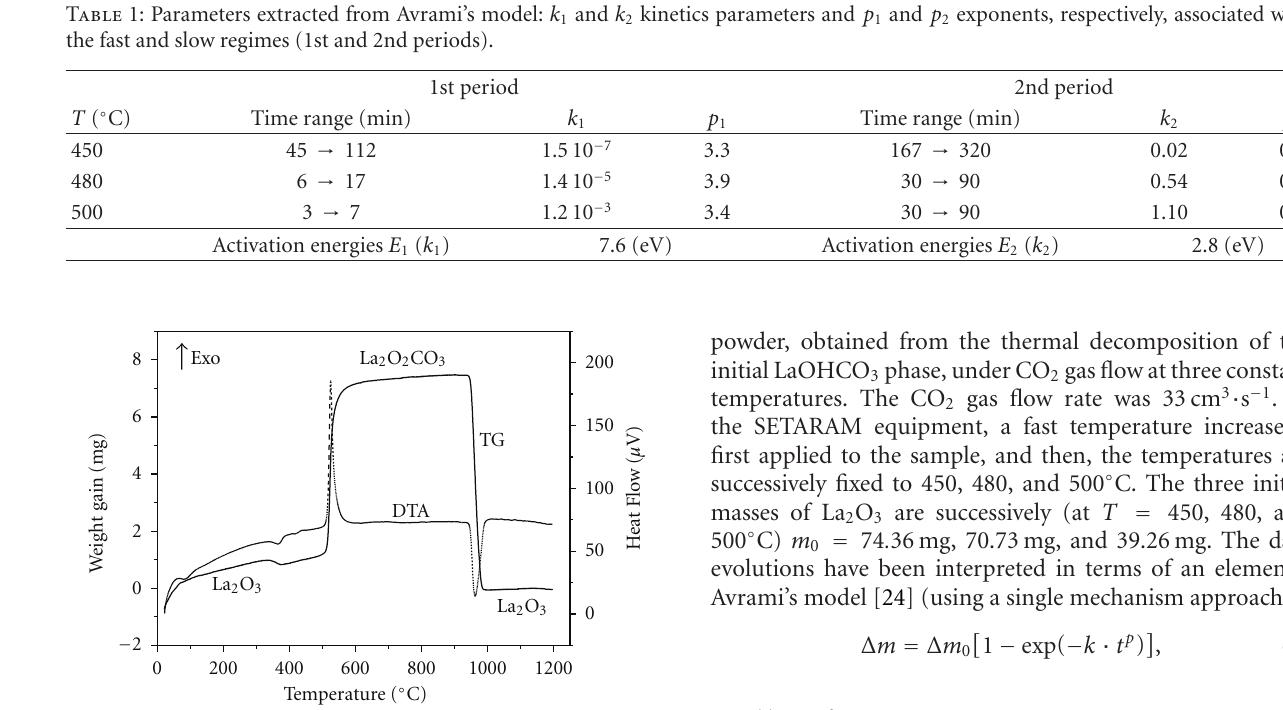
Figure 1: Weight gain associated with carbonatation of La 2 O 3 (first step): exothermic peak at 520 ◦ C linked with weight gain due to formation of the monoclinic La 2 O 2 CO 3 phase; endothermic peak due to decarbonatation of La 2 O 2 CO 3 phase and formation of final La 2 O 3 (second step).